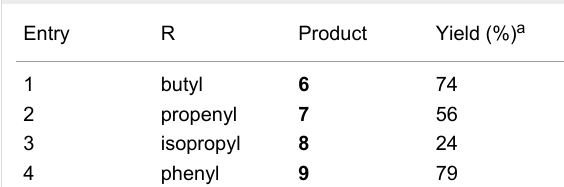
Table 2: Substitution of 1,2,4-triazine 1 by different amides 2–5